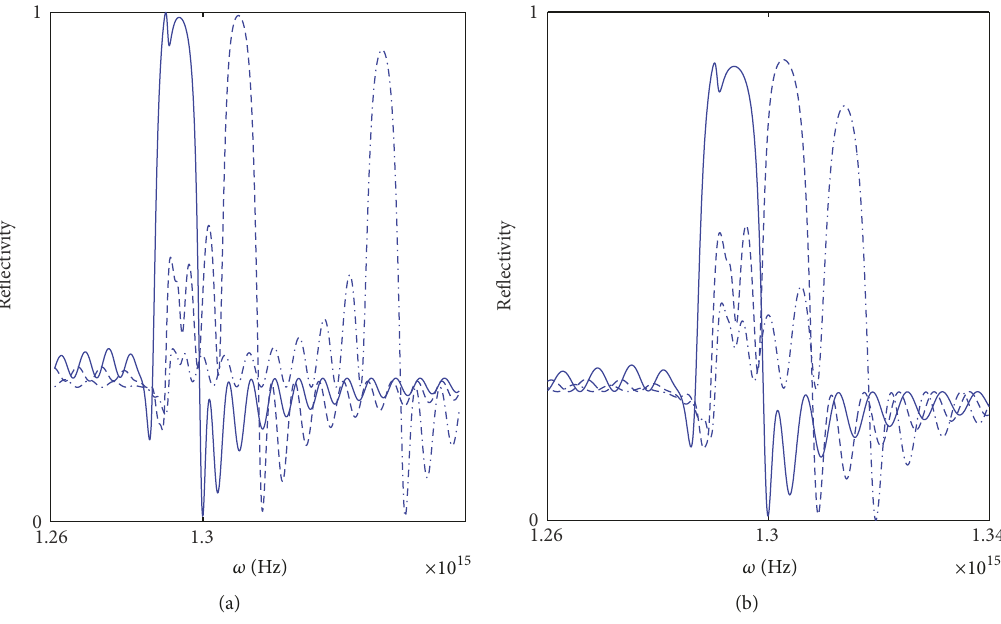
Figure 6: (a) Reflectivity of 200-periodic InGaAs/InP quantum well for 𝜃 = 0 ∘ (solid line), 𝜃 = 30 ∘ (dashed line), and 𝜃 = 60 ∘ (dashed-dot line). (b) Effect of width error in the switch performance. The solid line shows the reflectivity with no error. The dashed line shows 1nm error of both quantum barrier and well width on the reflectivity. Dashed-dot line shows 2 nm error of quantum barrier and well width on the reflectivity. (b) illustrates the effect of 1 nm and 2 nm width errors showed by dashed and dashed-dotted lines, respectively, on the reflectivity of InGaAs/InP MQW in normal incident. Resultantly, we see that even 1nm width error causes a shift from resonance frequency and the reflection will also be suppressed slightly. Besides, 2 nm width error on the quantum barrier and well width results in a significant impact on the switch performance and the system will completely be